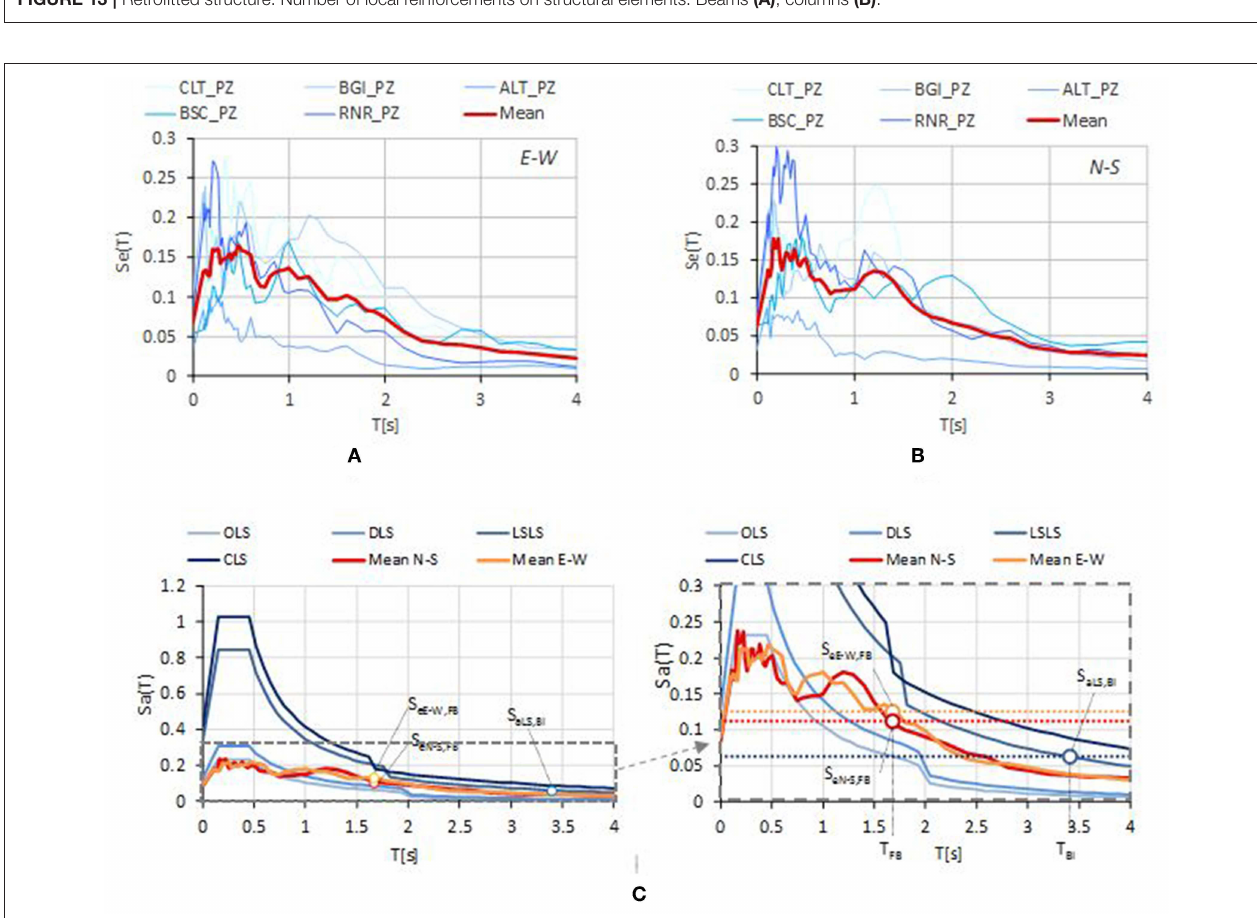
FIGURE 13 | Retrofitted structure: Number of local reinforcements on structural elements. Beams (A) , columns (B) .